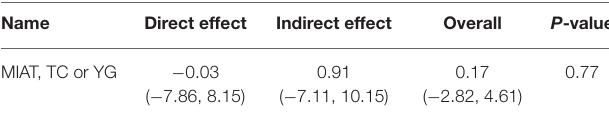
TABLE 3 | The results of the node splitting